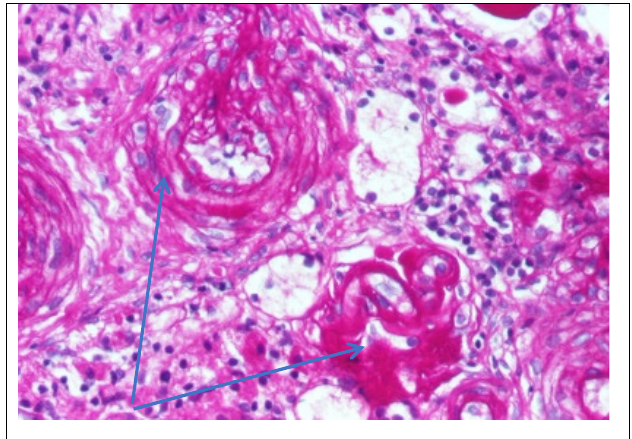
Figure 3. Kidney biopsy ( hematoxylin - eosin staining × 100)—Glomeruli and hyalinized vessels (blue arrow).